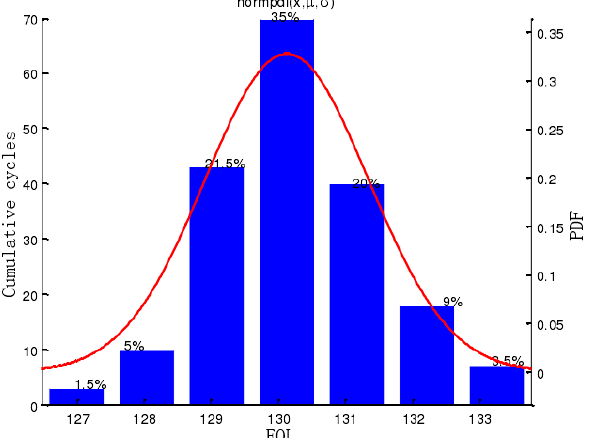
Figure 12. The PDH of LSTM prediction results at T2 = 89.